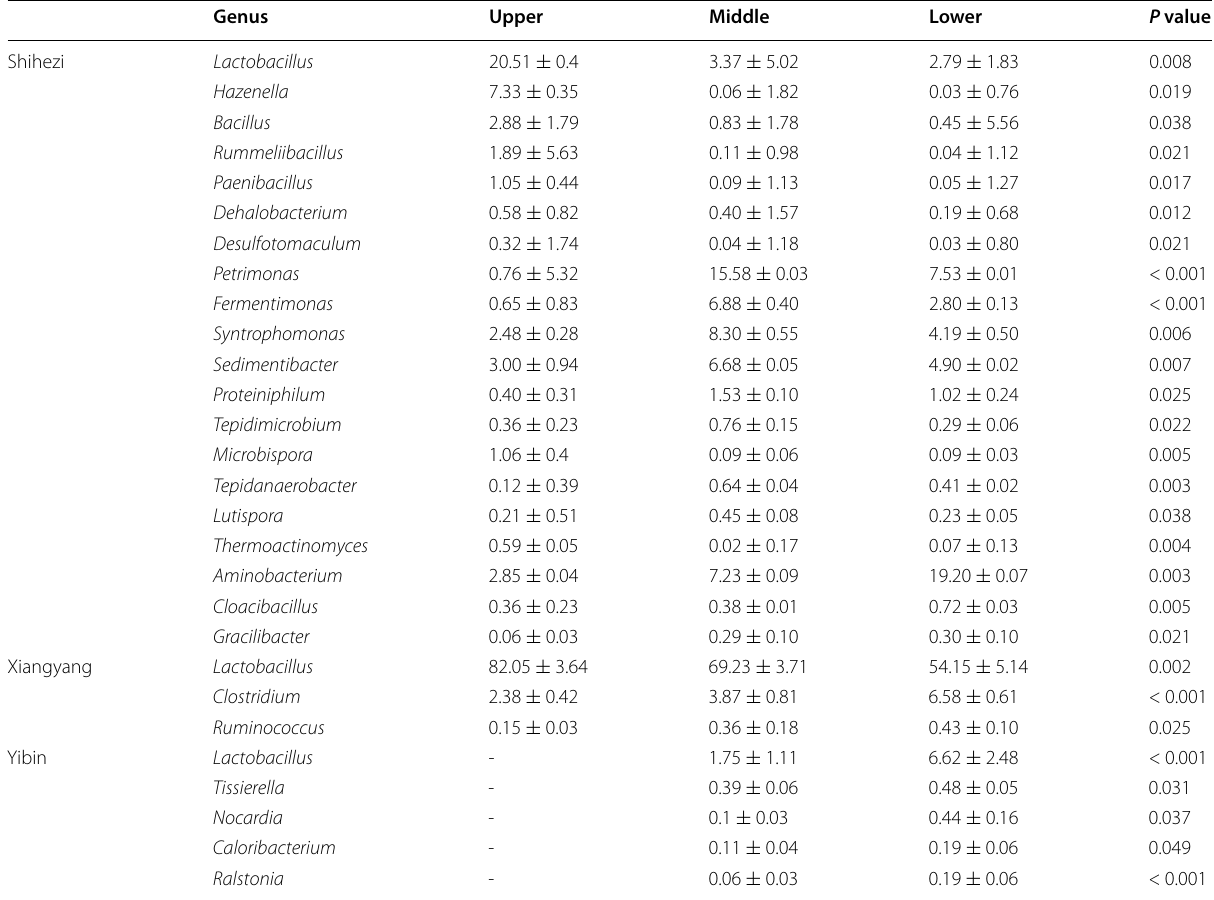
Table 1 Genera showing significant differences in abundance at different depths in the three regions Genus Upper Middle